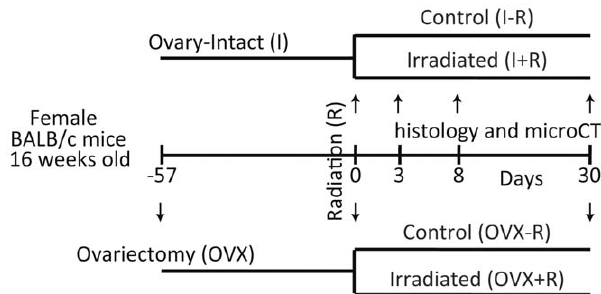
Figure 1. Experimental Plan Schematic. Sixteen week old BALB/c mice were ovariectomized (OVX) and maintained in the vivarium for 57 days in order to attain skeletal hemostasis. Both intact (I) and OVX mice were then irradiated with 16Gy delivered to the caudal skeleton or maintained as controls. Groups of animals were euthanized at 3, 8, and 30 days post irradiation in order to perform histological evaluations of the distal femur; microCT measurements were conducted at the 30 day time point